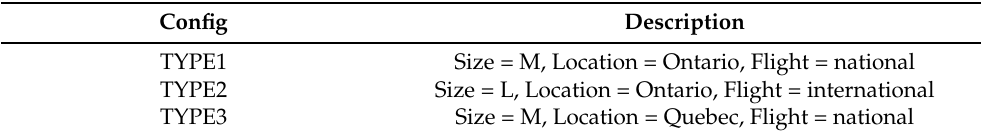
Table 1. Mapping configurations to their detailed